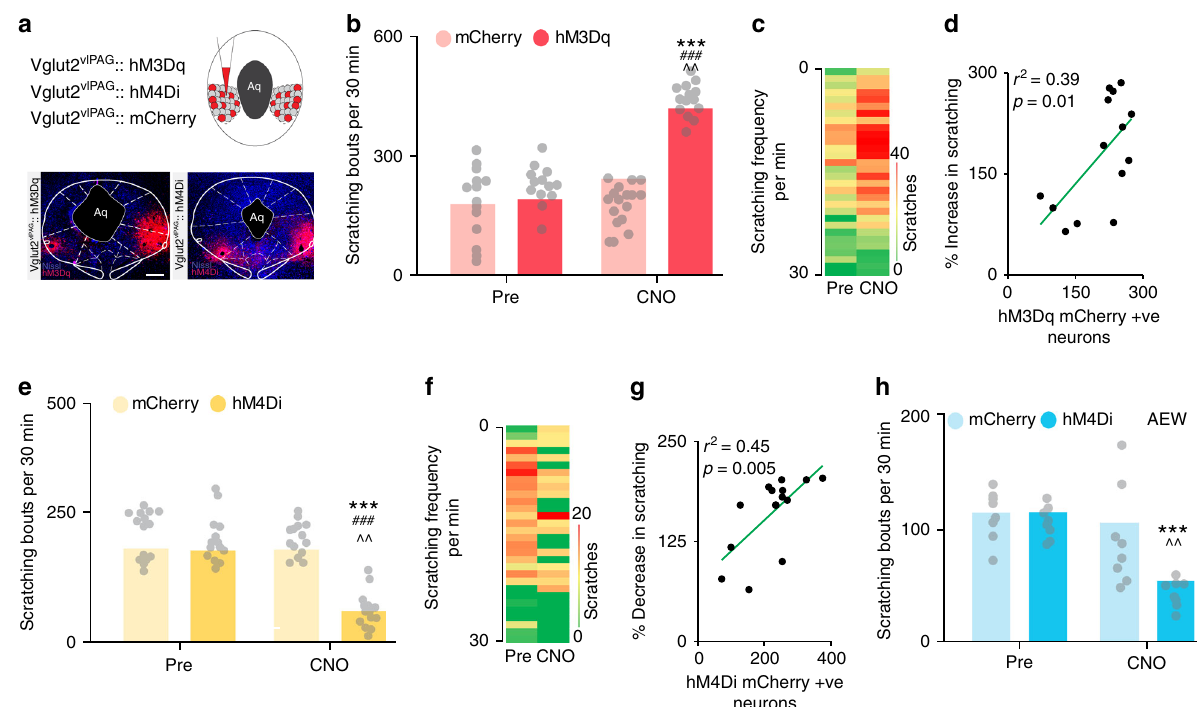
Fig. 7 vlPAG glutamatergic neurons bidirectionally modulates itch. a Illustration showing viral targeting strategy of AAV5-hSyn-DIO-hM3Dq – mCherry, AAV5-hSyn-DIO-hM4Di – mCherry and AAV5-hSyn-DIO-mCherry bilaterally injected into the vlPAG of Vglut2 Cre mice. Representative images of coronal sections containing vlPAG showing restricted viral expression following microinjection of AAV5-hSyn-DIO-hM3Dq – mCherry and AAV5-hSyn-DIO- hM4Di – mCherry in the vlPAG of Vglut2 Cre mice. b CNO (5 mg/kg, i.p) had no signi fi cant effect on chloroquine evoked scratching in Vglut2 Cre mice expressing the control mCherry construct in the vlPAG. However, CNO (5 mg/kg, i.p) administration resulted in signi fi cant increase in chloroquine evoked scratching in mice that express hM3Dq in the vlPAG of Vglut2 Cre mice. Interaction; F (1, 26) = 40.17, *** P < 0.0001. Pre vs. CNO; F (1, 26) = 91.06, ^^ P = 0.0001. mCherry vs. hM3Dq; F (1, 26) = 99.35, ### P < 0.0001. N = 14/group. Two-way ANOVA. c Heat map showing per-minute averaged